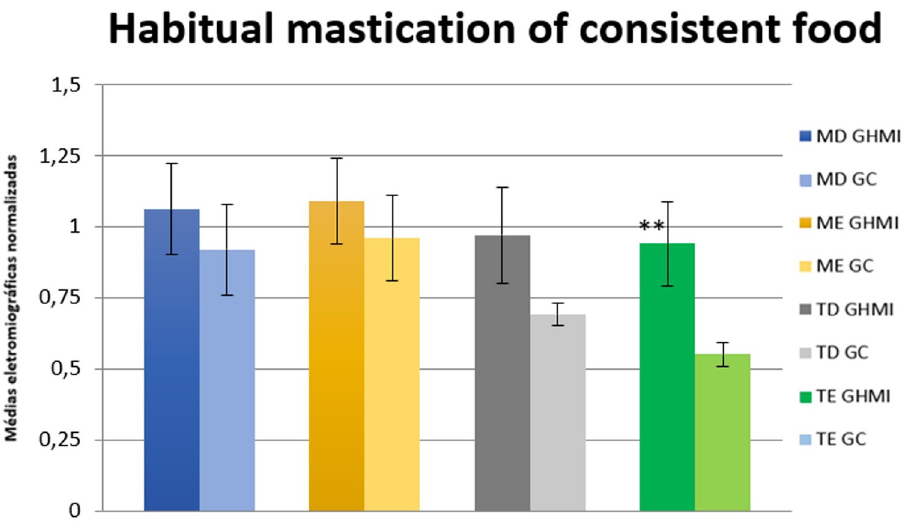
Fig 6. Normalized electromyographic means (RMS) in the habitual mastication of consistent food condition for the right masseter (RM), left masseter (LM), right temporal (RT) and left temporal (LT) muscles, in the MIH (MIHG) and control (CG) groups. MIH, Molar-incisor